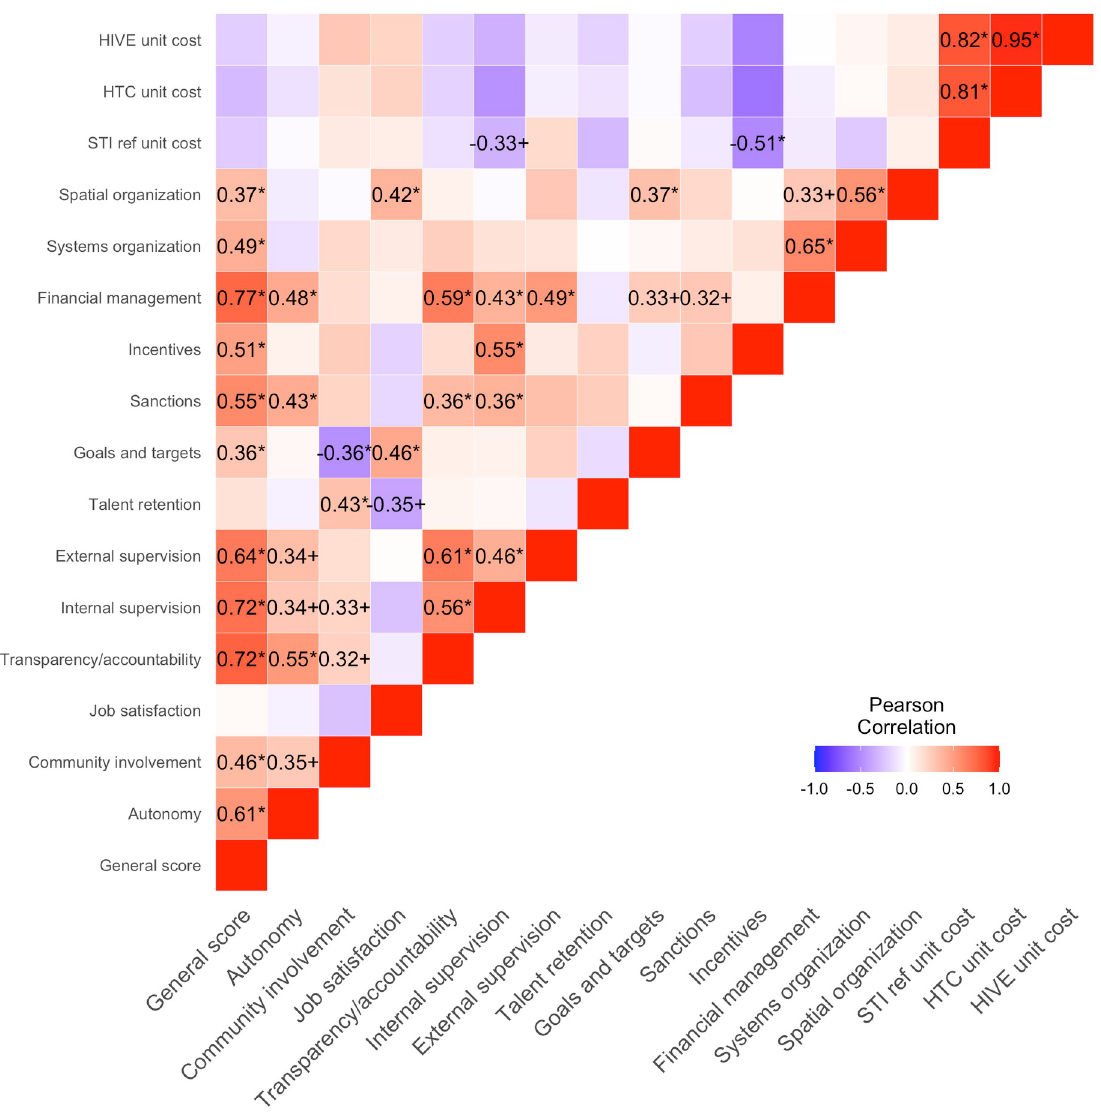
Fig 7. Correlations between unit costs and all management practices among community-based organizations providing HIV prevention services in Nigeria in 2016 (n = 31). Note: � p < 0.05, + p < 0.1.